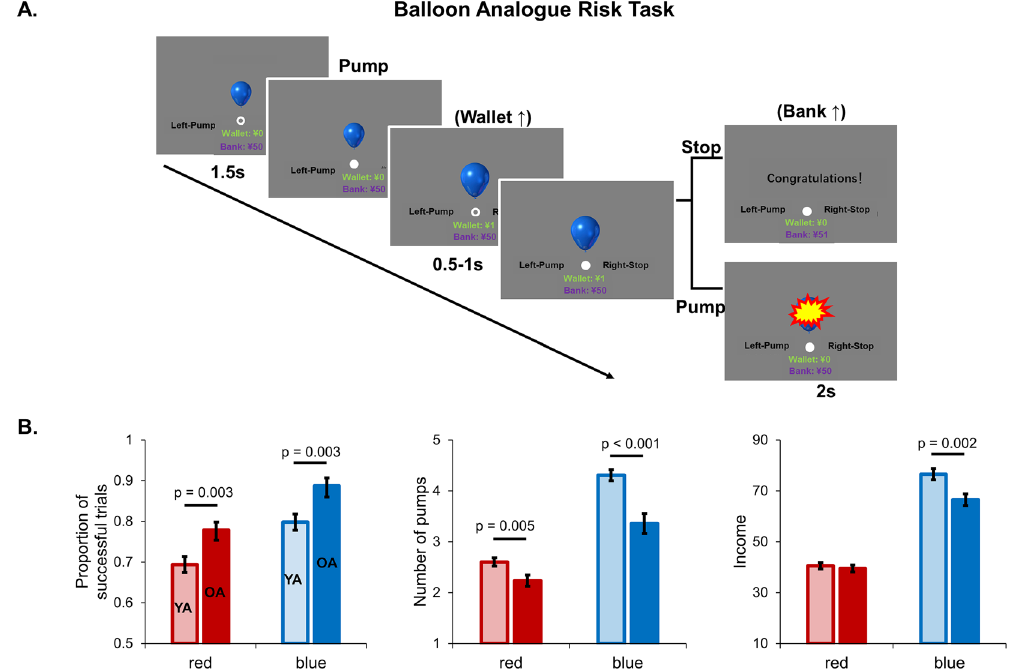
Figure 1. The BART paradigm and overall performance. ( A ) At the beginning of each trial, a fixation of white circle was displayed at the center of the screen for 1.5 s. After the fixation turned to a white disc, participants could increase monetary earnings in the “wallets” by inflating the balloon. The money in the “wallet” would be successfully transferred to the “bank” if participants stop pumping before balloon explosion, or it would be lost (feedback 2 s). The inter-trial interval was jittered pseudorandomly between 2 and 4 s. ( B ) Compared with young adults, older adults showed significantly higher ratio of successful trials, decreased average adjusted number of pumps, and lower income. Note: young adults, light color; older adults, dark color.